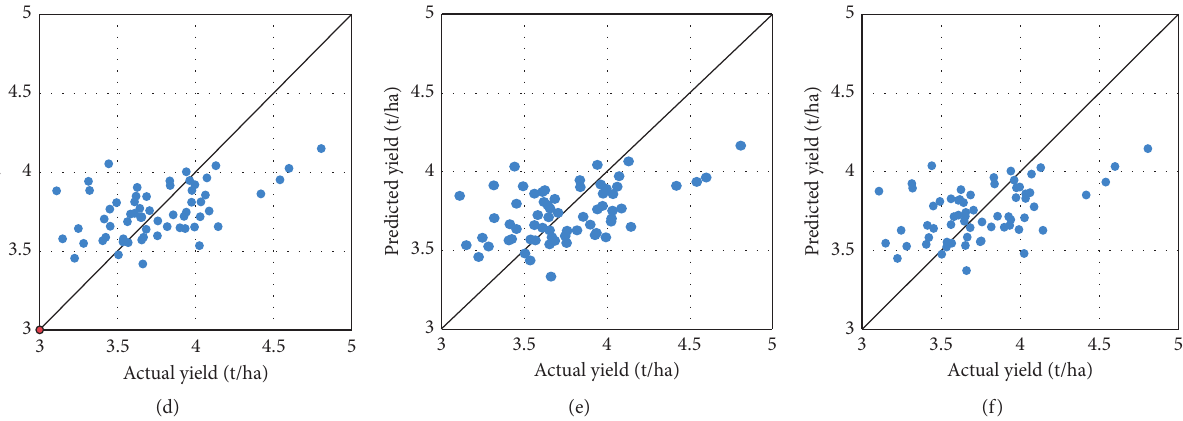
Figure 3: The plot of actual vs. predicted yield after combining all the seasons and districts. (a) ANN. (b) SVMR. (c) GPR. (d) MLR. (e) PR. (f) RR. Table 3: Performance of the models for the combined dataset. Parameter